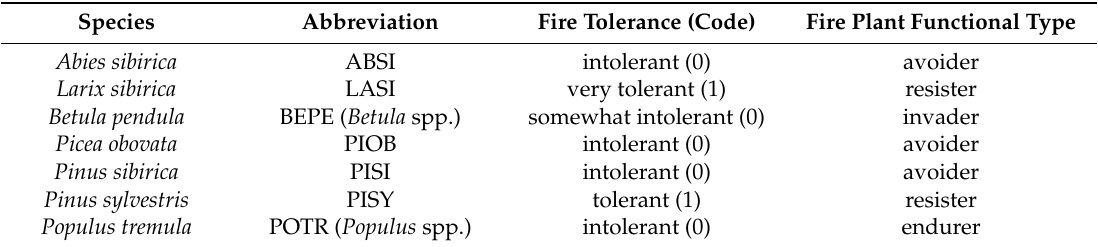
Table 1. Fire tolerance is used to determine which species survive a ground fire. All trees are assumed to die in a crown